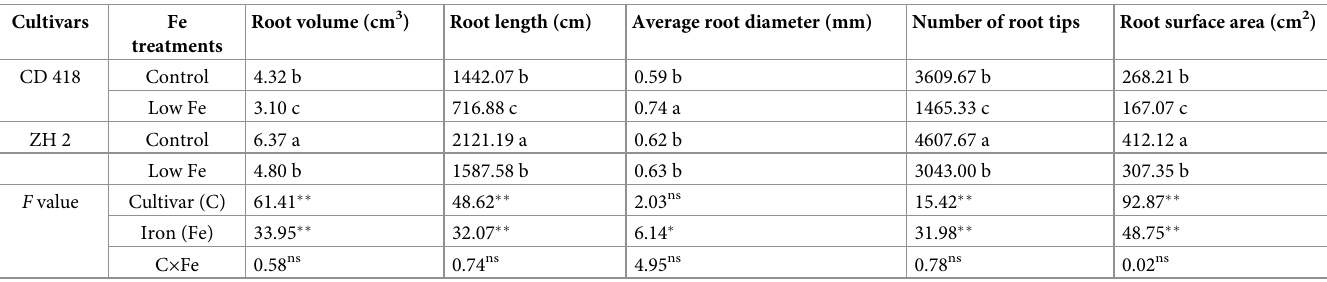
Table 3. Root morphological characteristics of maize